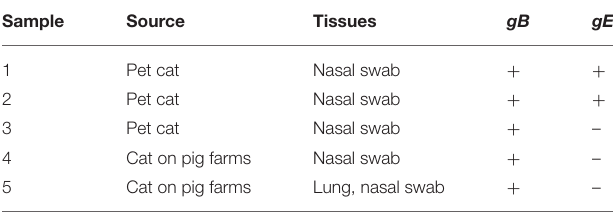
TABLE 1 | Viral detection in a retrospective survey.